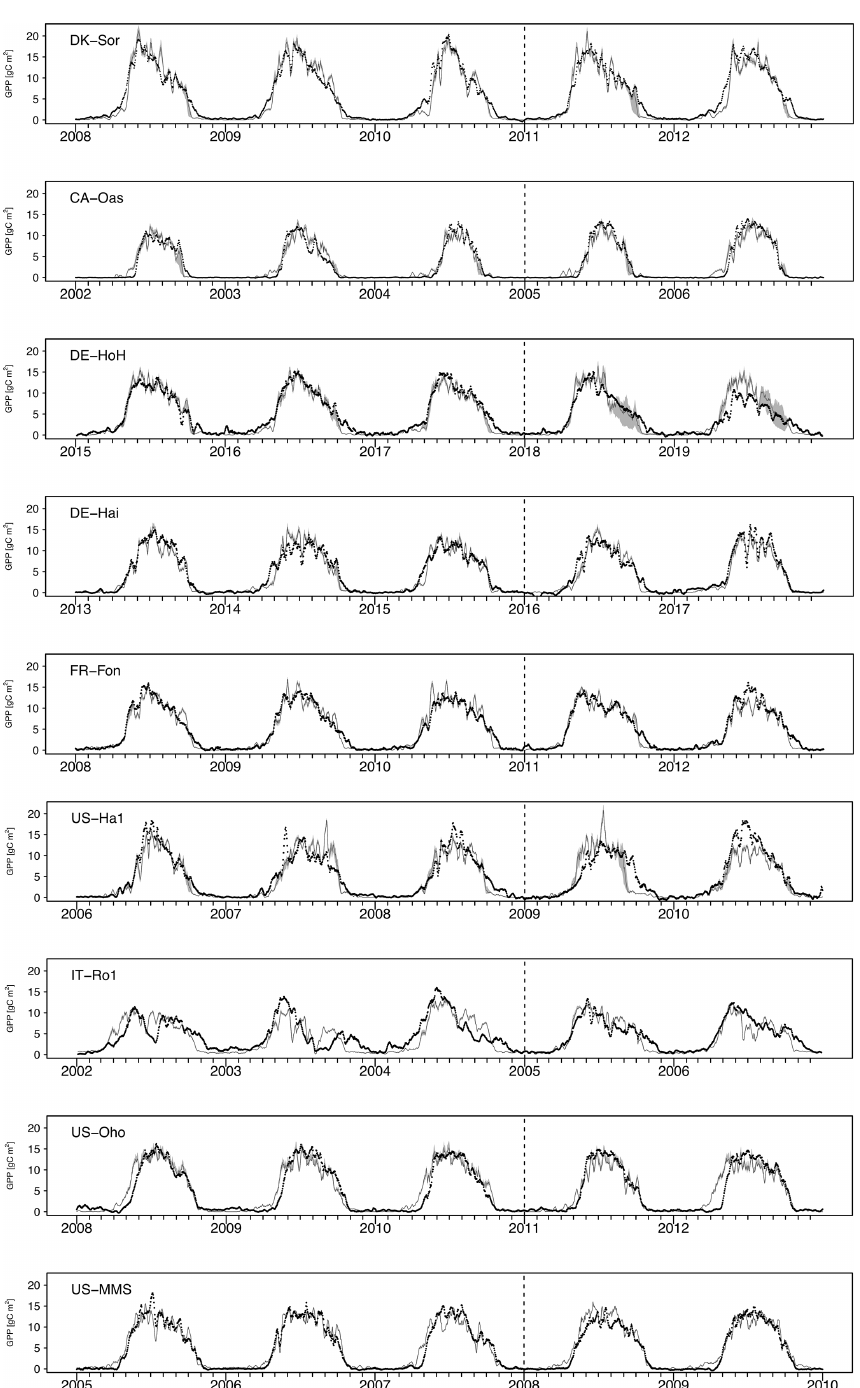
Figure 5. Time series of observed and simulated GPP at each study site during the last 3 years of calibration and the first 2 years of validation. The vertical dashed line marks the calibration–validation periods. The black dots indicate the tower-estimated GPP. The light gray, shaded area corresponds to the resultant ensemble output members at each time step. The dark gray line refers to the median of ensemble members.